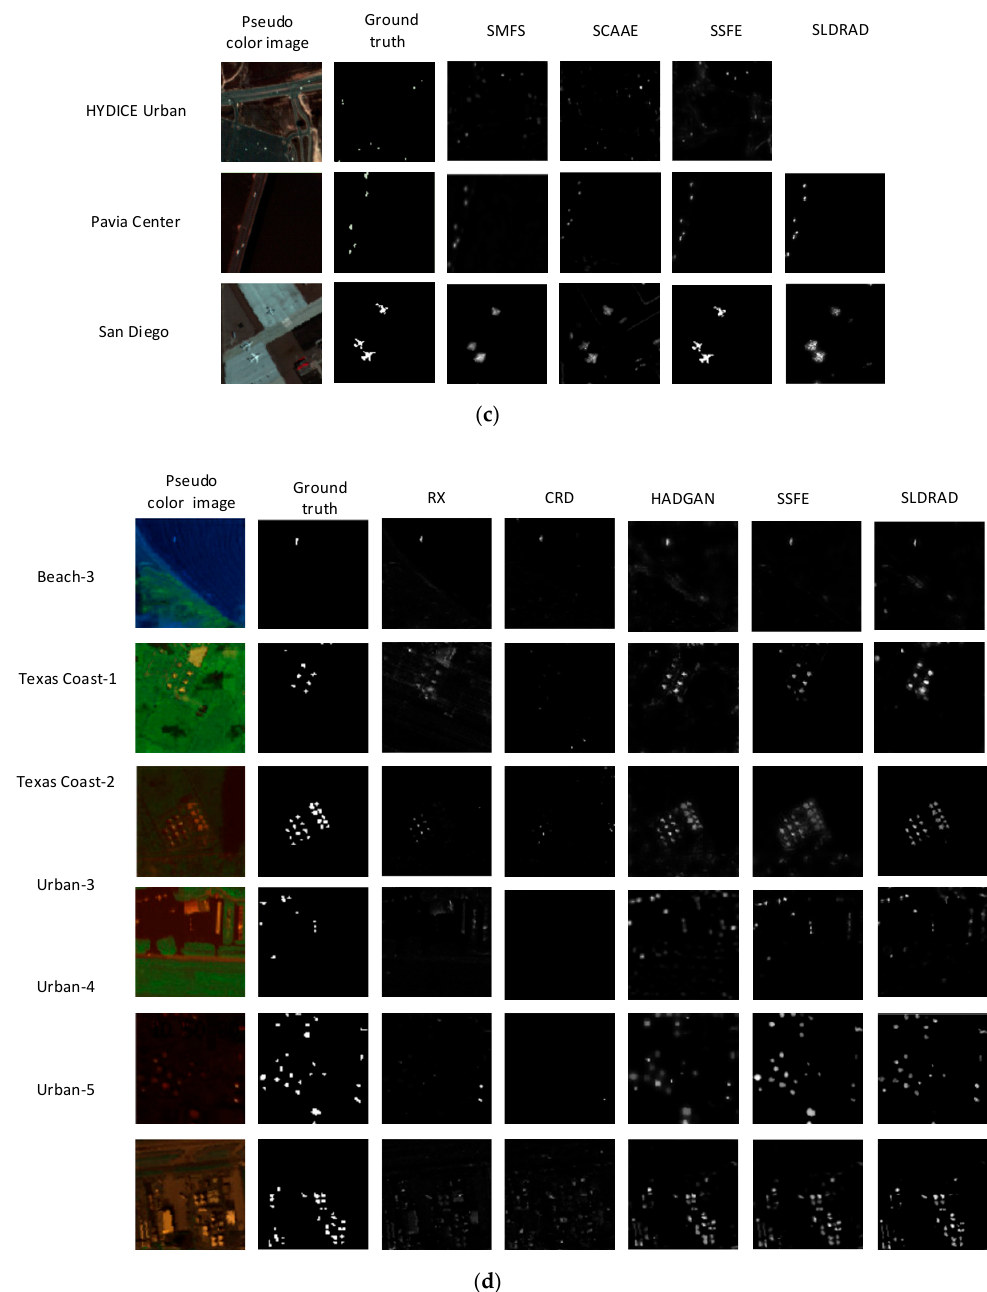
Figure 4. ( a – d ) Anomaly detection effects of different methods on different hyperspectral datasets (comparison of partial methods and none methods is in Appendix A).